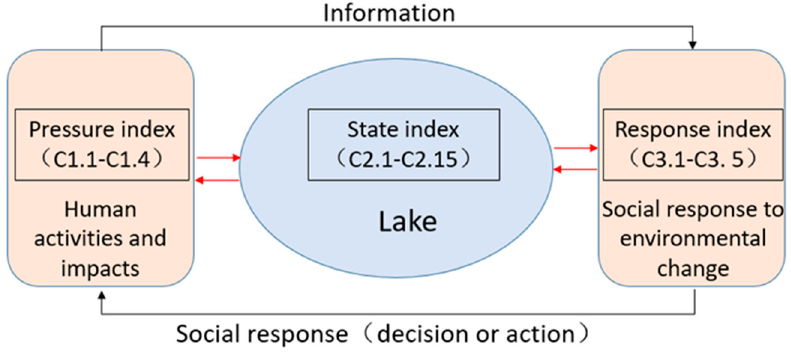
Figure 6. Relationships between modules in the pressure–state–response (PSR) framework.